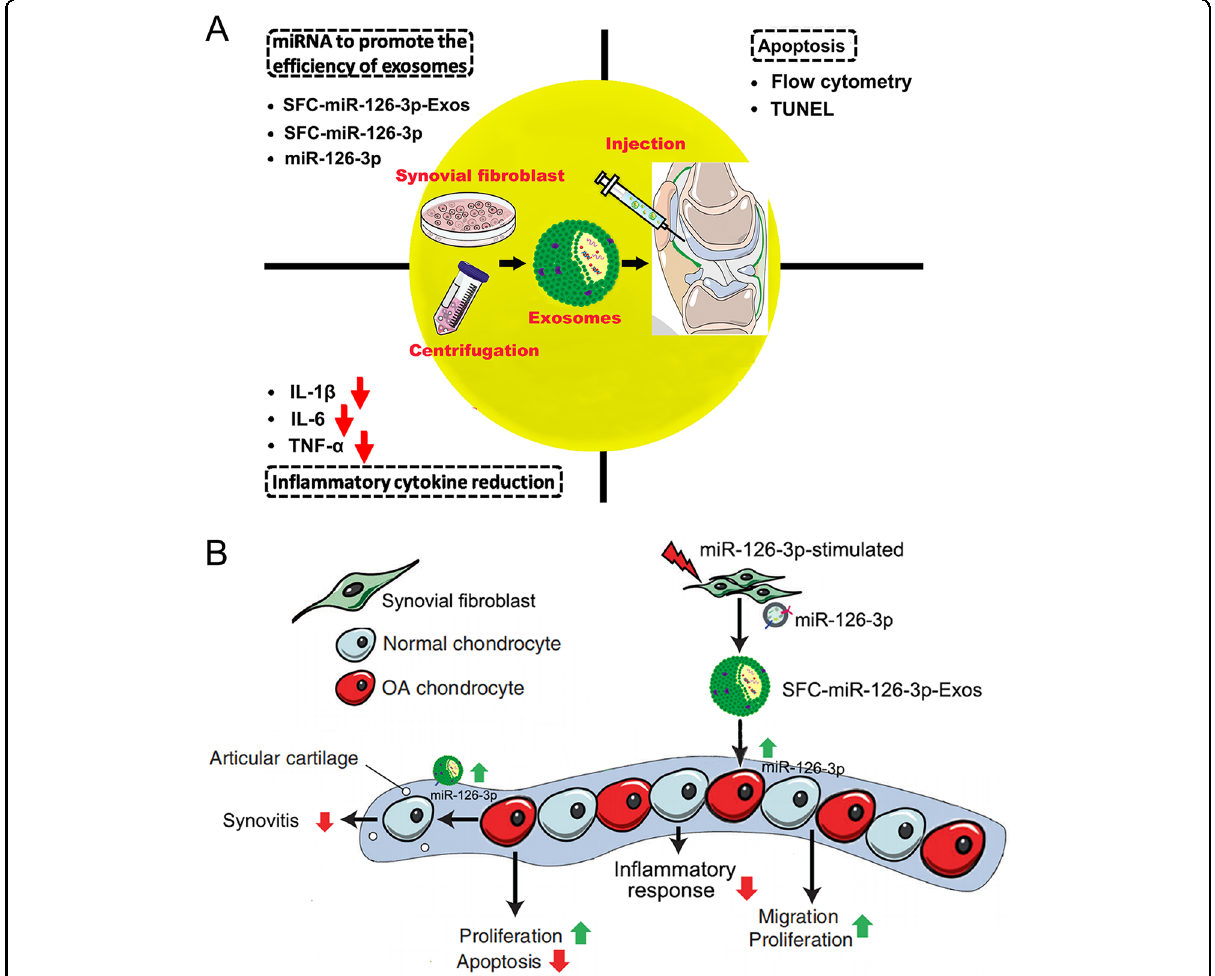
Fig. 7 Proposed mechanism of SFC-miR-126-3p-Exos interference with OA chondrocyte in fl ammation and cartilage degradation. A The therapeutic effects of SFC-derived exosomes on OA are mainly re fl ected in the following three parameters. (1) reduction of in fl ammatory cytokines, (2) inhibition of apoptosis, and (3) modulate miRNA-126-3p in exosome to promote the therapeutic ef fi ciency. B The exosomes derived from SFC could mediate cell – cell communications and regulate diverse cell phenotype including in fl ammatory reaction, cell proliferation, migration, apoptosis and